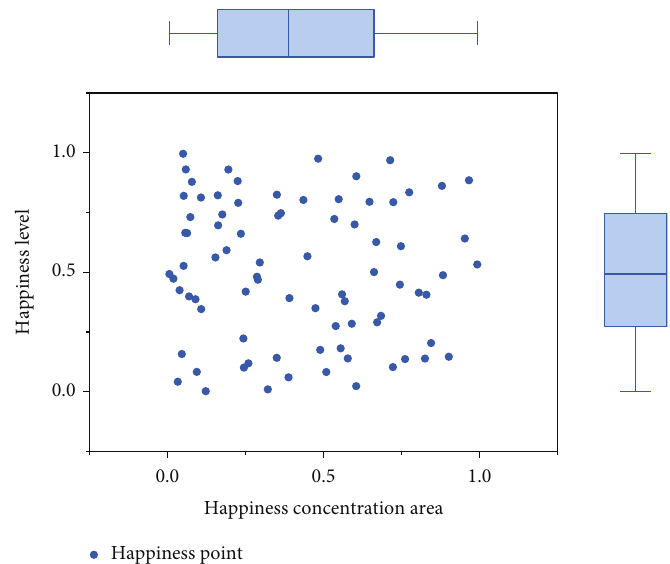
Figure 5: Impact of mobile social media sharing behavior on Internet users ’ happiness.